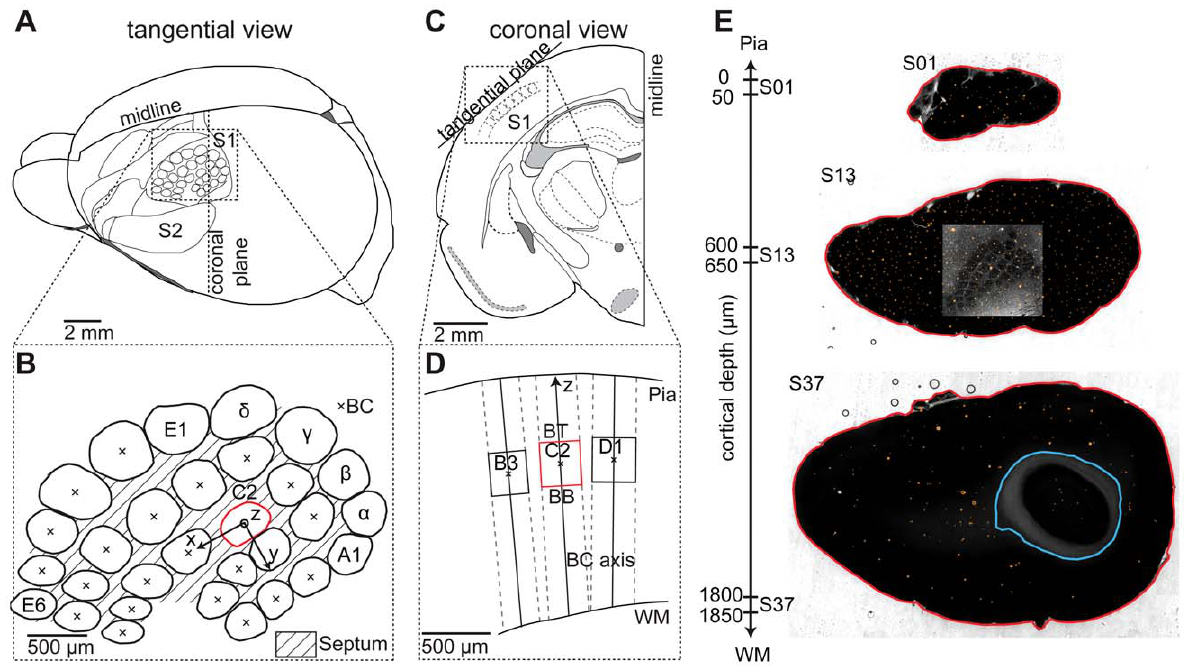
Figure 1. 3D parameterization of barrels and barrel columns in rat vibrissal cortex. (A) Tangential view of the left hemisphere of a rat brain. The barrel field is located in the primary somatosensory cortex (S1), adjacent to the secondary somatosensory cortex (S2). (B) The barrels are arranged in a somatotopic layout of rows (A–E) and arcs (1–6). The four barrels in front of the first arc are given greek labels ( a - d ). The barrel center (BC) is the centroid of a barrel and is used to describe the 3D location of individual barrels. The coordinate system used to describe the 3D layout of the barrel field based on the position of the BCs is centered on the C2 barrel (red), which is centrally located within the barrel field. The z axis points vertically along the C2 barrel column axis, the x axis is chosen to point towards the C3 barrel center (approximately along the row) and the y axis is perpendicular to the x and z axes and points approximately along the arc. (C) View of a coronal section of the left hemisphere (see dashed line in a). Barrels can be visualized by preparing cortical sections tangential to the barrel cortex. (D) The barrel cortex is organized into vertical barrel columns. These are obtained by cylindrical extrapolation of the barrel outlines along their respective BC axis to the pia and subcortical White matter (WM), respectively. The location of a barrel along the BC axis is described by the barrel top (BT) and barrel bottom (BB) points. (E) Tangential sections through rat cortex, indicating the relative depth below the pia, with automatically detected anatomical landmarks: red – pia, blue – WM, orange – blood vessels. The inset in section S13 shows an example of a high-resolution optical section of the barrel